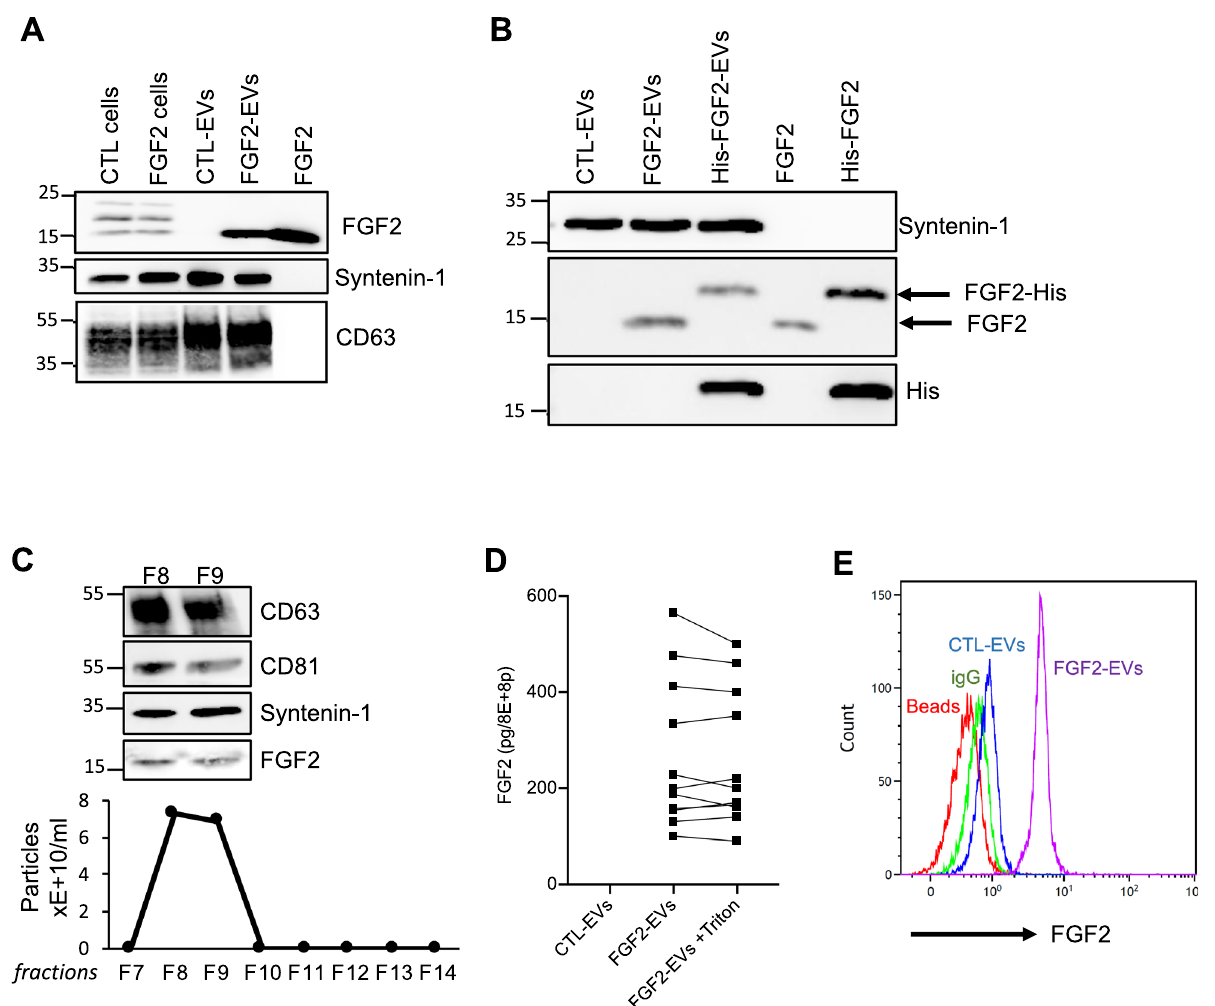
Figure 1. FGF2 is found at the outer surface of EVs secreted by dermal fibroblasts cultured in FGF2-containing medium. ( A ) FGF2, syntenin-1 and CD63 expression in DF cells and EV lysate (20 μg) was examined by western blot. Three isoforms of endogenous FGF2 were present in DF cells while FGF2-EVs contained the low molecular weight FGF2 isoform corresponding to recombinant FGF2. Original blots are shown in Suppl. Information. ( B ) Cells were cultured in the presence of His-tagged FGF2; western blot with 15 μg lysate and using anti- His antibody revealed the presence of His-FGF2 in secreted EVs. A shift in FGF2 size was also observed. Syntenin-1 was used as EV marker. Original blots are shown in Suppl. Information. ( C ) FGF2-EVs were loaded on a SEC column and collected fractions 8 and 9 (3E + 9p) were analyzed by western blot using antibodies for FGF2 and the EV markers CD63, CD81 and syntenin-1. Original blots are shown in Suppl. Information. For quantification, fractions were also analyzed by NTA. ( D ) FGF2 detection in FGF2-EVs by ELISA assay. Intact CTL- and FGF2-EVs (8E + 8p) were directly placed on FGF2 ELISA wells for external surface detection. FGF2- EVs were also treated with 0.1% triton and analyzed to detect internal FGF2. No FGF2 signal was detected in CTL-EVs. ( E ) FGF2 expression on FGF2-EVs was detected by flow cytometry. EVs were coupled to latex beads and labeled with FGF2 antibody before analysis by cytometry. Beads without EVs (beads) and beads labelled with goat IgG antibody (IgG) serve as negative controls. A representative plot is